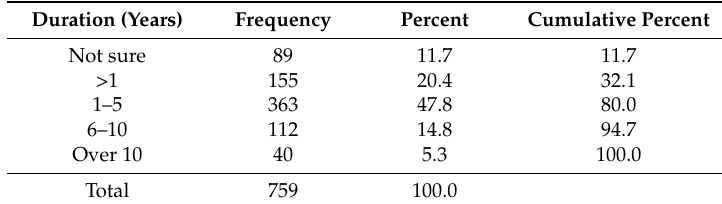
Table 4. Duration of using e-Procurement technologies.